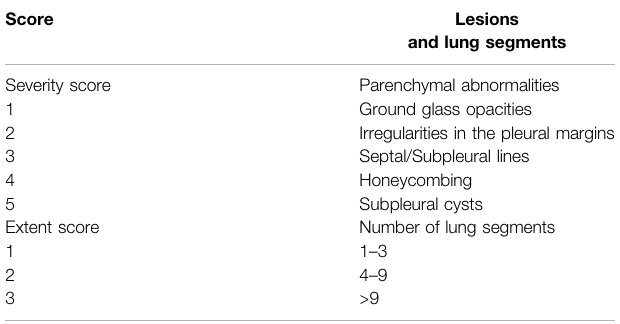
FIGURE 1 | Patient fl ow chart.